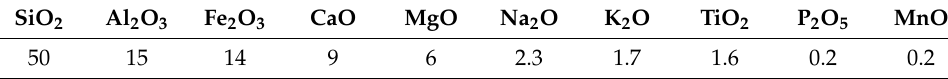
Figure 1. Geometrical models of the simulated SEM-EDS setup. ( a ) Circular section of a basalt-derived glass fibre embedded in a potassium-poly(sialate-siloxo) geopolymer matrix, with the electron beam focussed on the centre of the fibre top-surface. The silicon drift EDS detector was set with an elevation angle of 35°. ( b ) Example of spots for EDS microanalysis. The surface roughness of the sample is assumed not to influence the EDS analysis. Images created with the POV-Ray software. Table 1. Oxides mass fraction (wt%) of basalt-derived glass